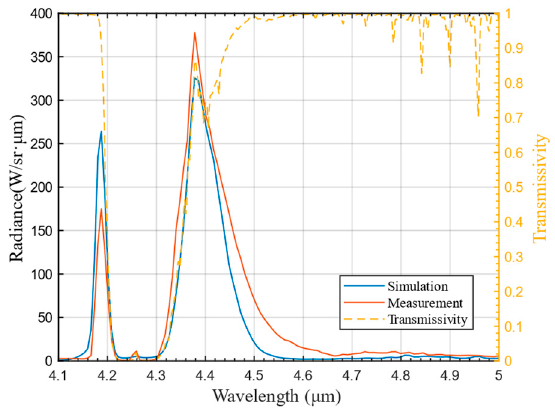
Figure 6. Comparison of plume measurement and simulation and atmospheric transmittance at 20 m horizontal path.